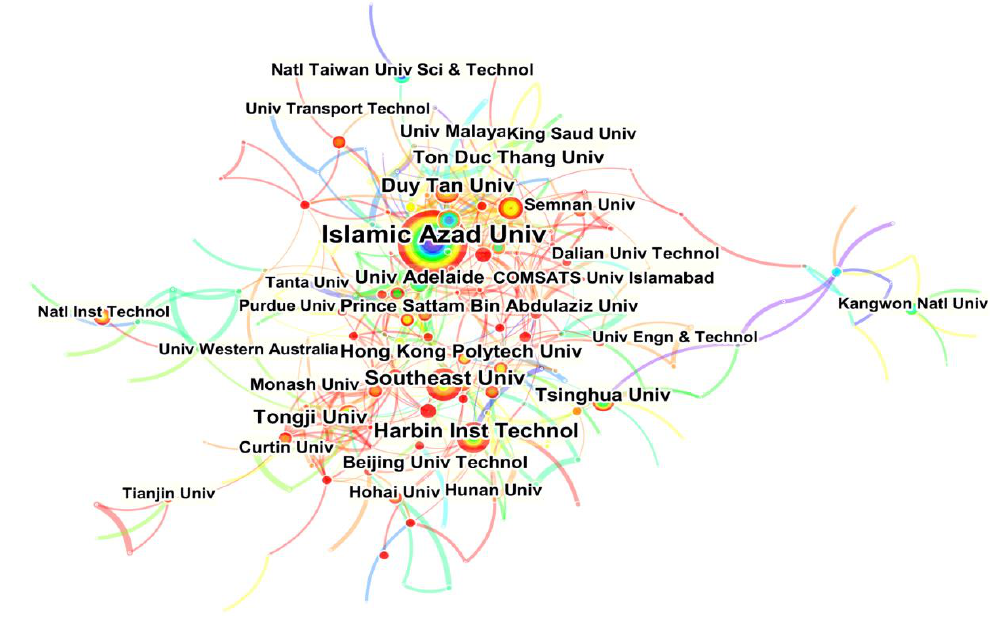
Figure 5. Collaborative network of research institutions.